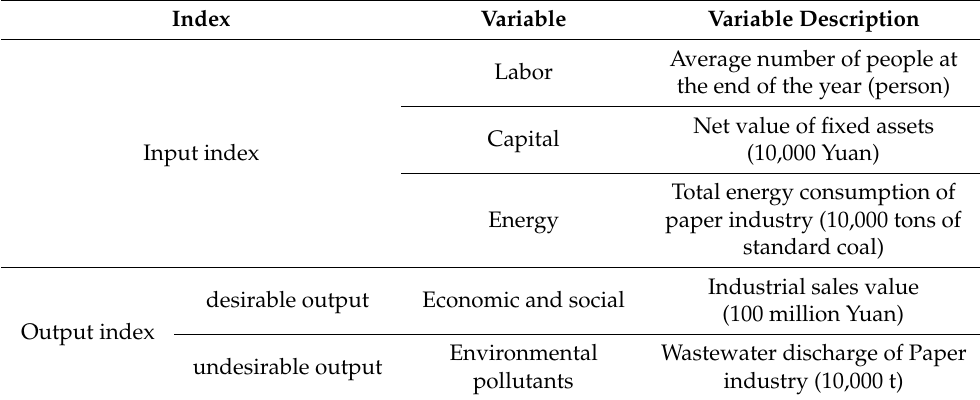
Table 2. Measurement index of green development efficiency of the paper